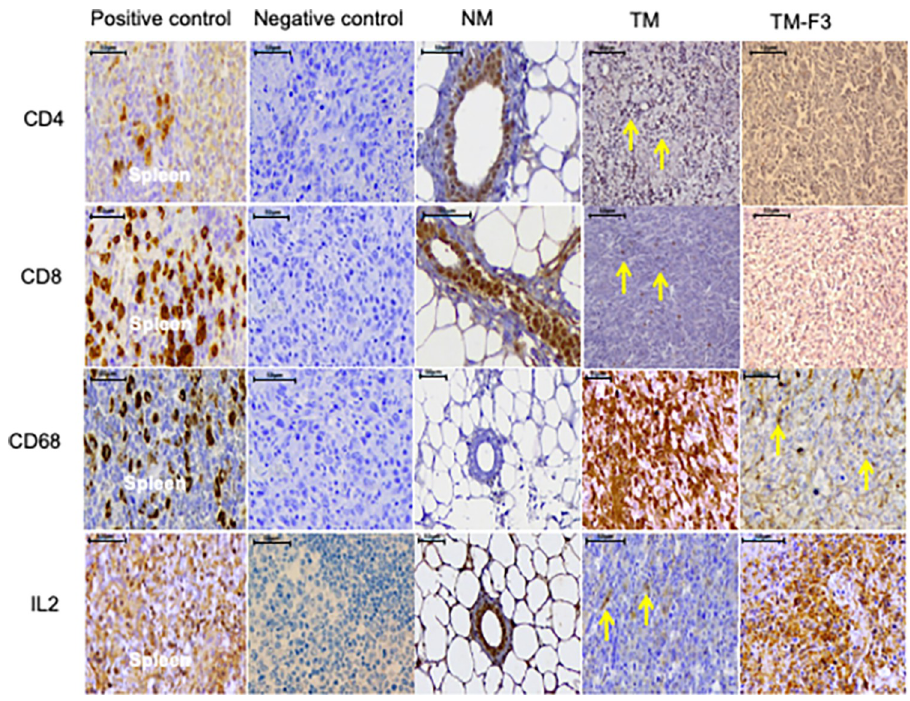
Fig 4. Representative photomicrographs showing expression of CD4, CD8, CD68 and IL-2 in treated and untreated tumors. Arrows indicate positively stained lymphocytes (CD4 & CD8), macrophages (CD68) and mammary tumor cells (IL2). Images were captured at X400 magnification. The scale bar corresponds to 50 μ m.